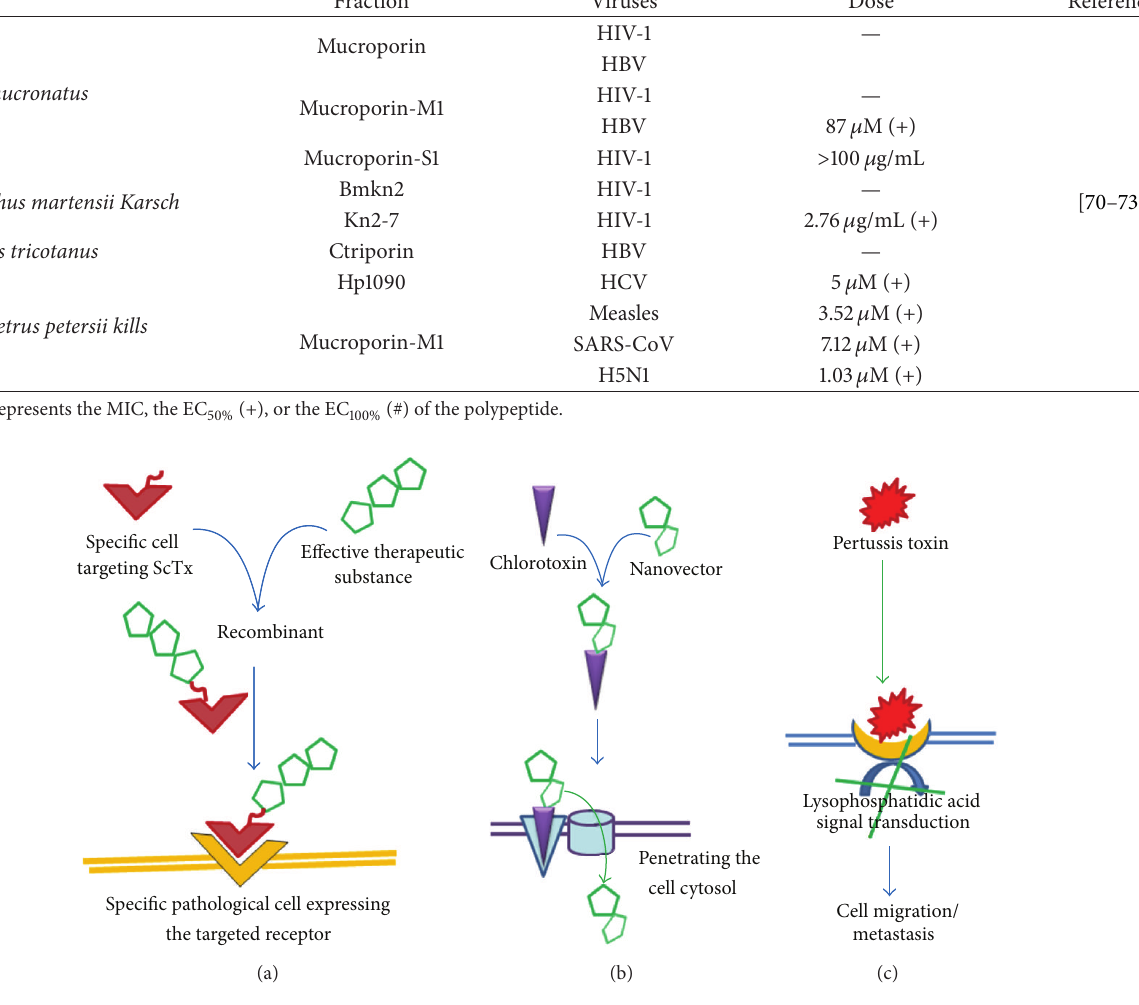
Figure1:Schematicproposedmodelsforscorpiontoxinsuseincancerandmetastasistherapy.Scorpiontoxinsaredottedwithhighspecificity to targeted specific cells receptors enabling them to be potent candidate for drugs carrier. (a) Radioactive iodine delivery into brain gliomas using chlorotoxin as a guider to target cancerous cells. (b) The chlorotoxin triggers gene transfection for cancer cells therapy. (c) Direct effect of pertussis toxin in abolishing metastasis. It did inhibit migration (evasion) through blocking the transduction signal of the lysophosphatidic acid